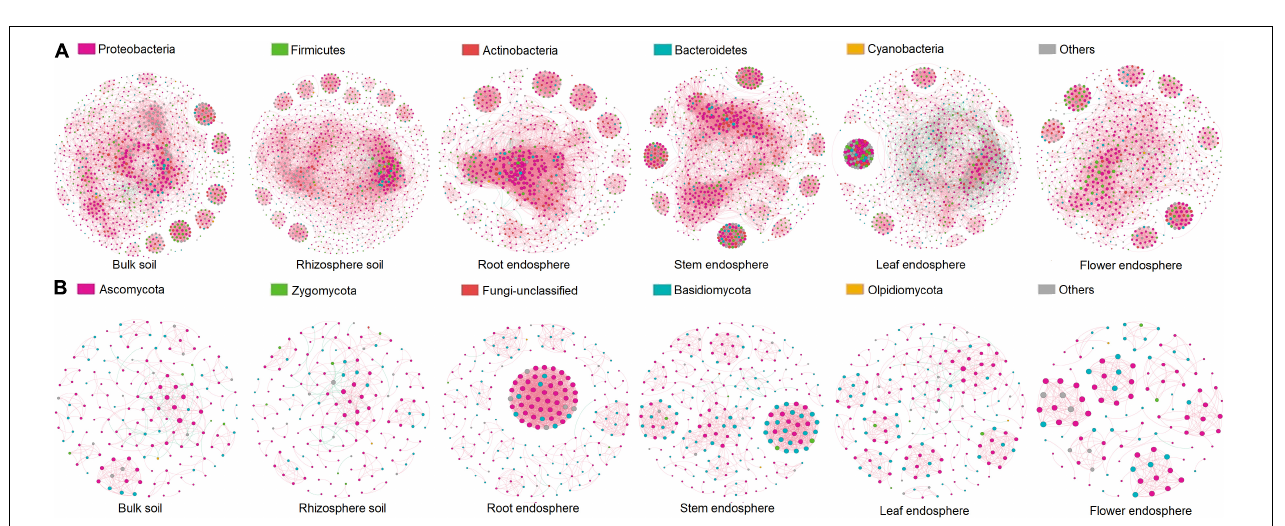
FIGURE 5 | Co-occurrence network analysis of microbial communities associated with hemp plants. (A) Bacteria. (B) Fungi.